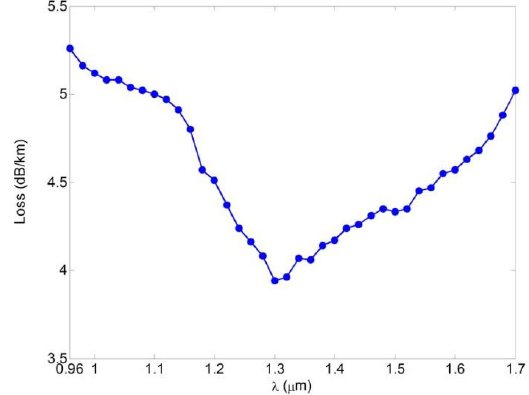
Figure 8. Attenuation of manufactured 520 m length of LOMF 100/125.